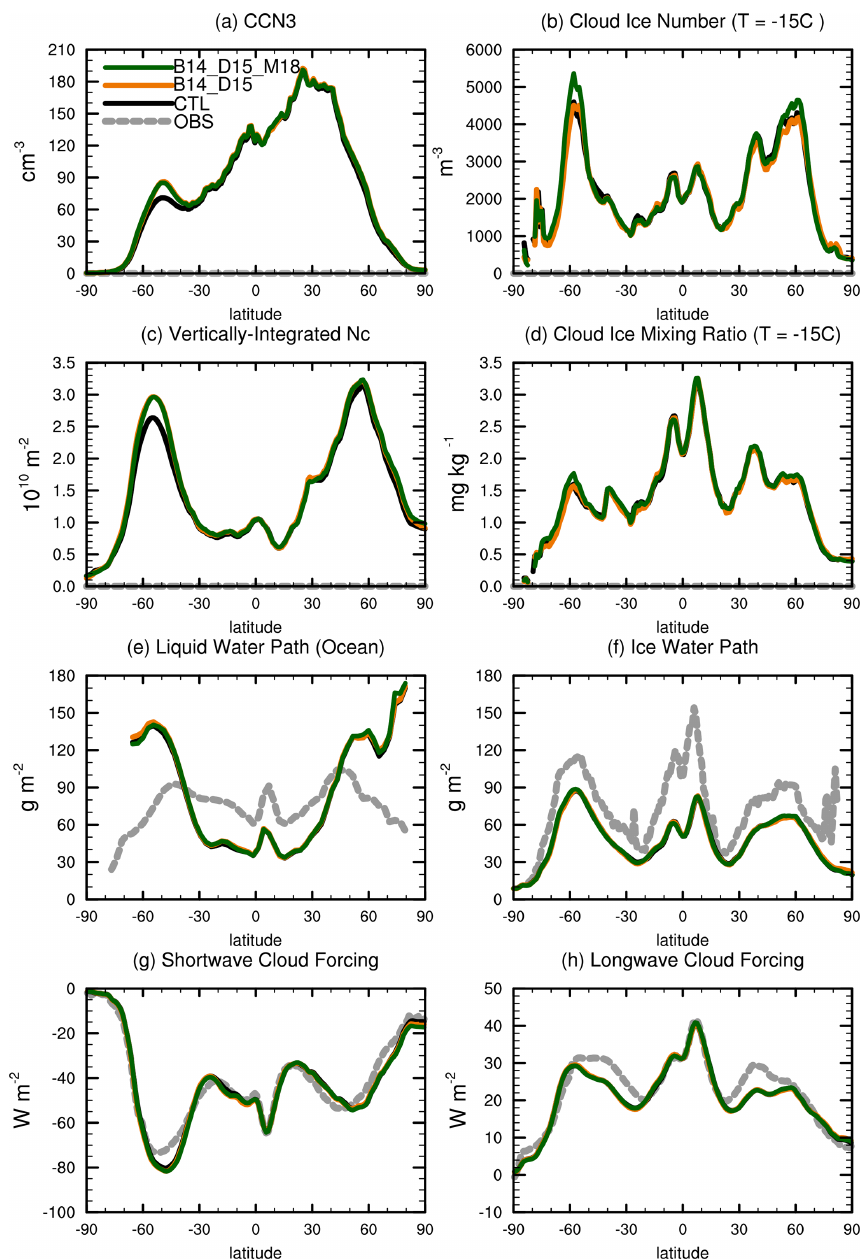
Figure 8. Annual zonal-mean distributions of (a) surface CCN concentration at S = 0.1%; (b) cloud ice number concentration on T =− 15 ◦ isotherm level; (c) vertically integrated cloud droplet number concentration; (d) cloud ice mass mixing ratio on T =− 15 ◦ isotherm level; (e) liquid water path over ocean; (f) ice water path; (g) shortwave cloud forcing; and (h) longwave cloud forcing for CTL (black), B14_D15 (orange), and B14_D15_M18 (green), along with available observations (dashed gray lines) as a reference. The − 15 ◦ isotherm level was selected in panels (b) and (d) to better represent the mixed-phase cloud